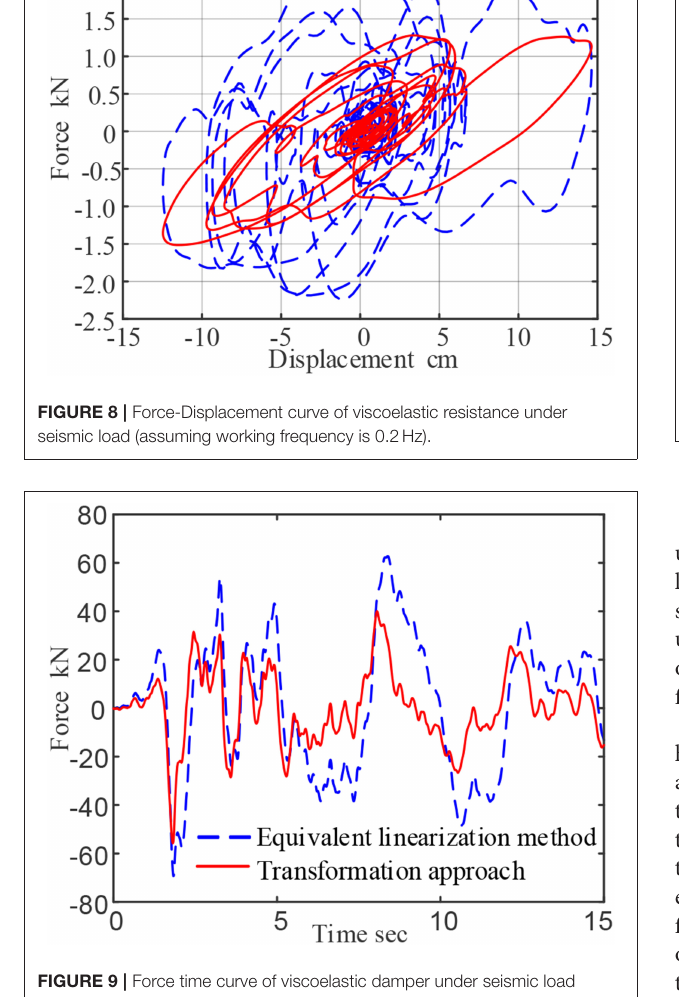
FIGURE 9 | Force time curve of viscoelastic damper under seismic load (assuming working frequency 5Hz).